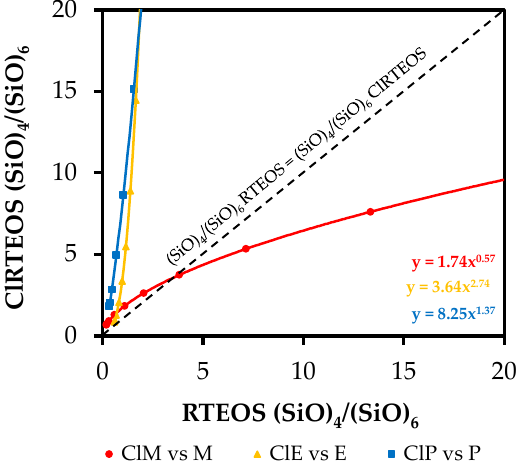
Figure 9. Variation in the proportion of structures (SiO) 4 /(SiO) 6 of the chloroalkyl series with respect to the alkyl series at different molar percentages of precursor.